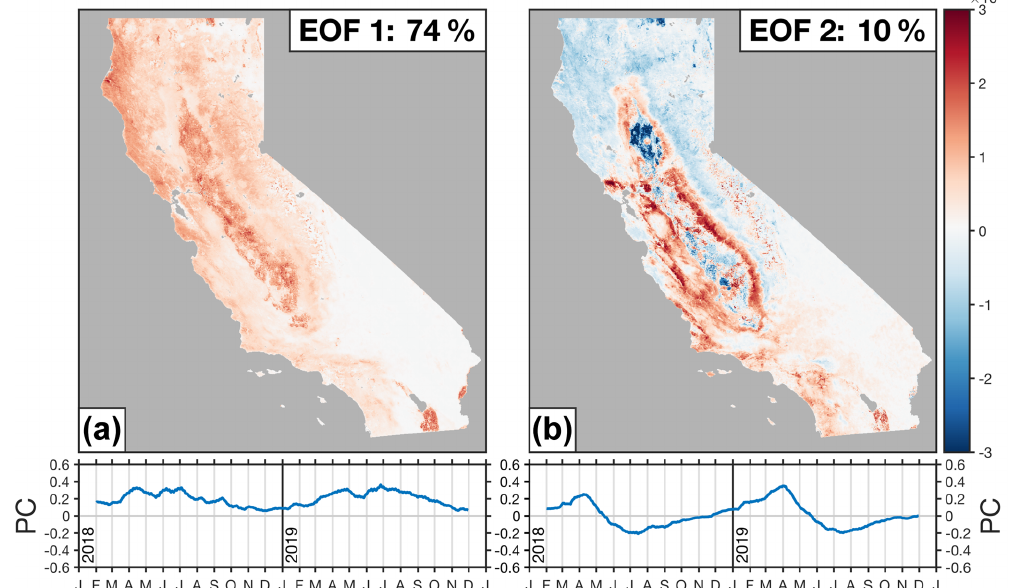
Figure 9. EOFs and PCs for TROPOMI SIF over California. Panels show the first two EOFs and PCs. EOFs are unit length (sum of the squares is equal to 1) and computed using unnormalized SIF spatially downscaled with NIR v . Time series show the corresponding PC (blue line) from February 2018 to November 2019. The length of the PC is equal to the corresponding eigenvalue and has units of mWm − 2 sr − 1 nm − 1 . The text in the figure lists the percent of variance explained by that EOF. Figure S5 shows the corresponding eigenvalue spectrum for the TROPOMI SIF data over